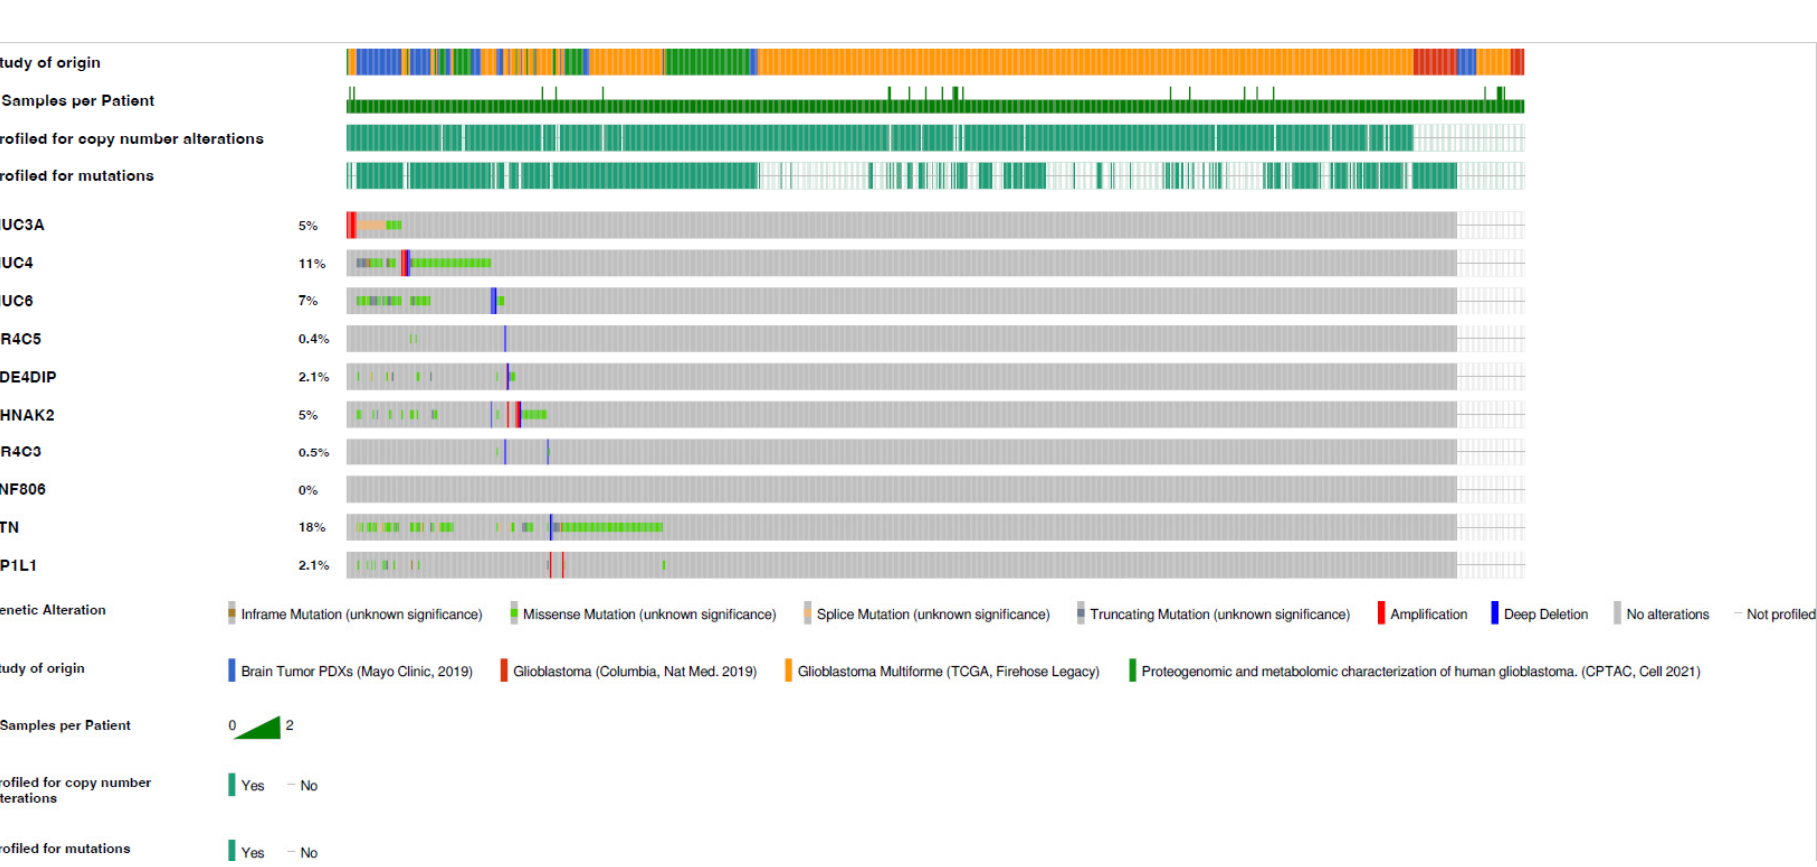
Figure 8. The percentage frequency of mutations in glioblastoma TCGA data for the top ten most mutated genes identified via Maftools from the five aggressive glioblastoma samples studied herein.